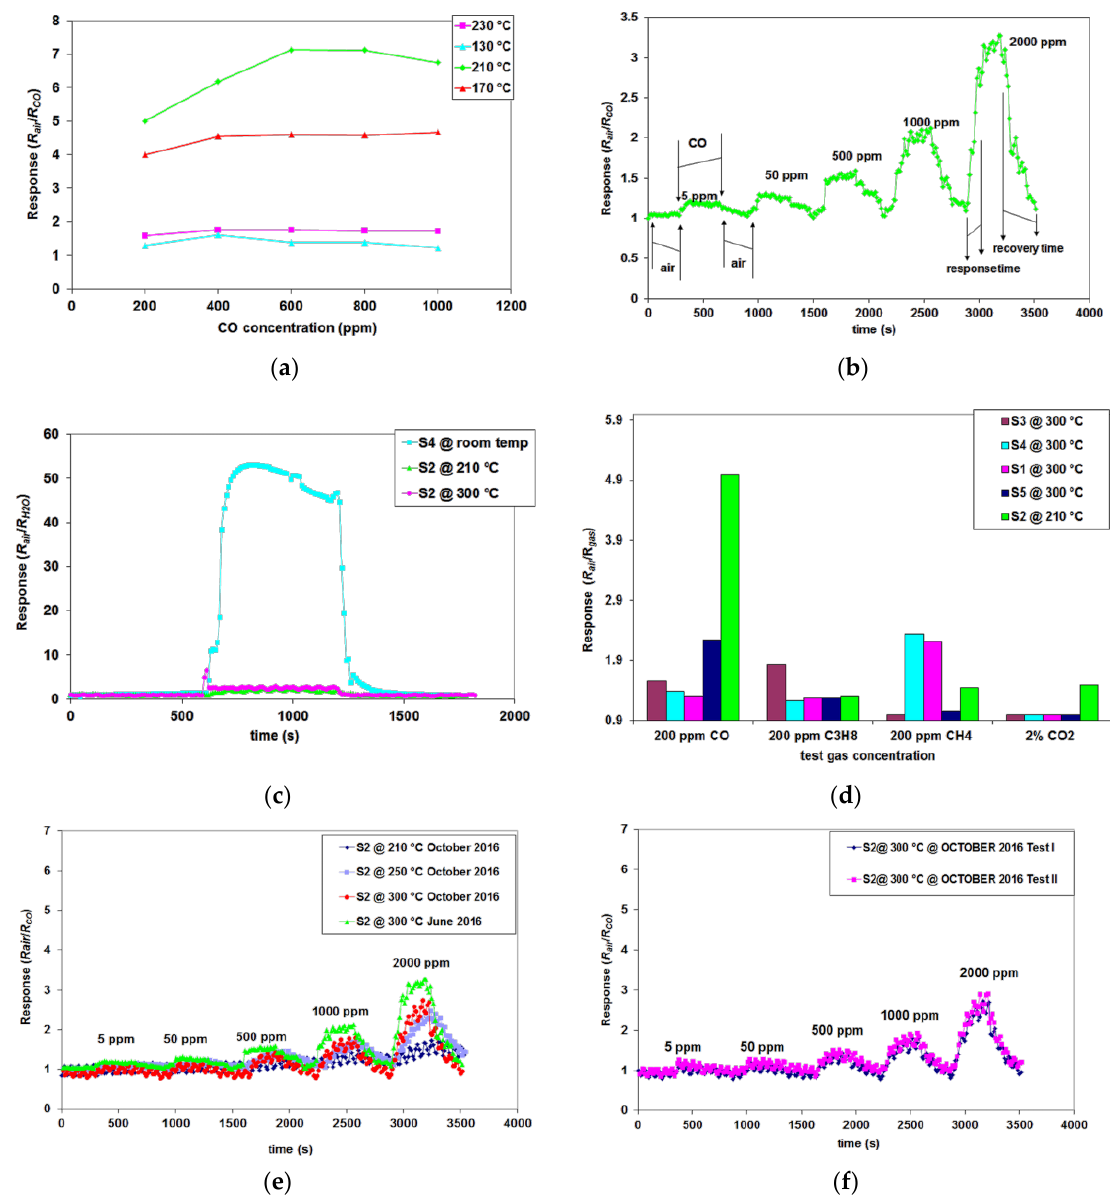
Figure 26. ( a ) S2 sensitivity for CO, at specific T w .; ( b ) S2 response/recovery characteristic for CO, at T w = 300 °C; ( c ) sensor response/recovery characteristics for 62% relative humidity (RH); ( d ) sensor series cross-sensitivity measurements; ( e , f ) S2 stability measurements, from ref. [126].